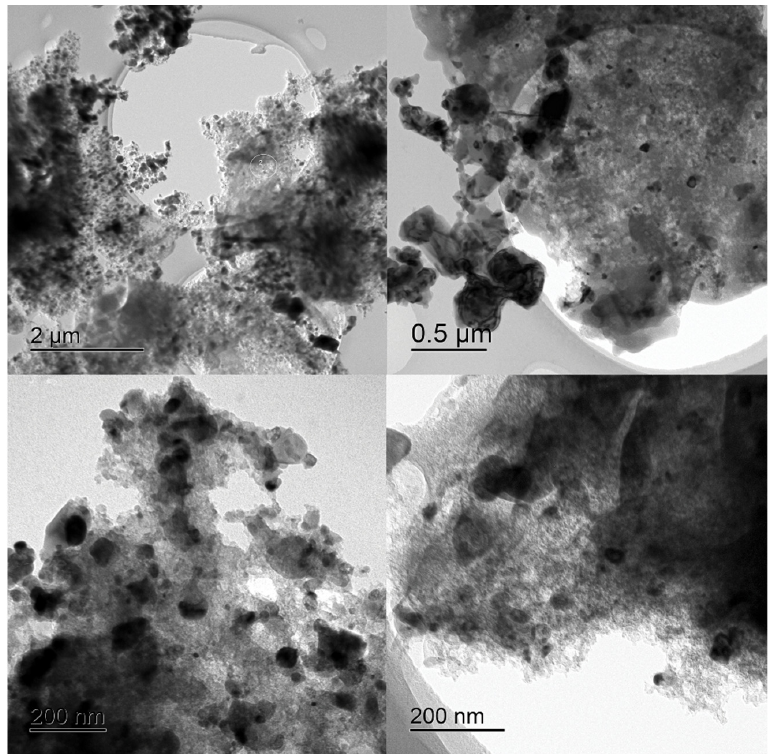
Figure 6. Transmission electron micrographs of a sample of the initial hydrolysis lignin after gasification.